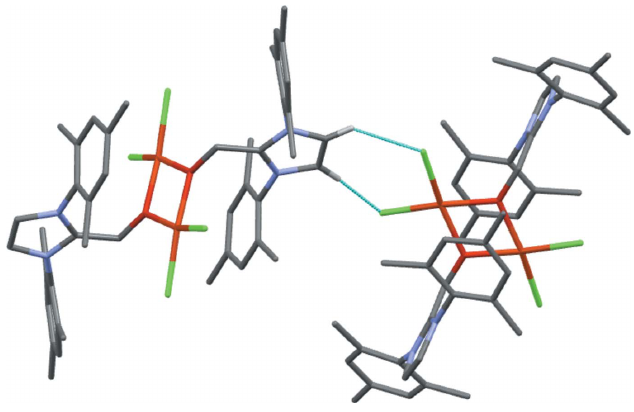
Figure 3 View highlighting the close Cl (cid:2)(cid:2)(cid:2) H contacts between neighbouring molecules of (I). See text for